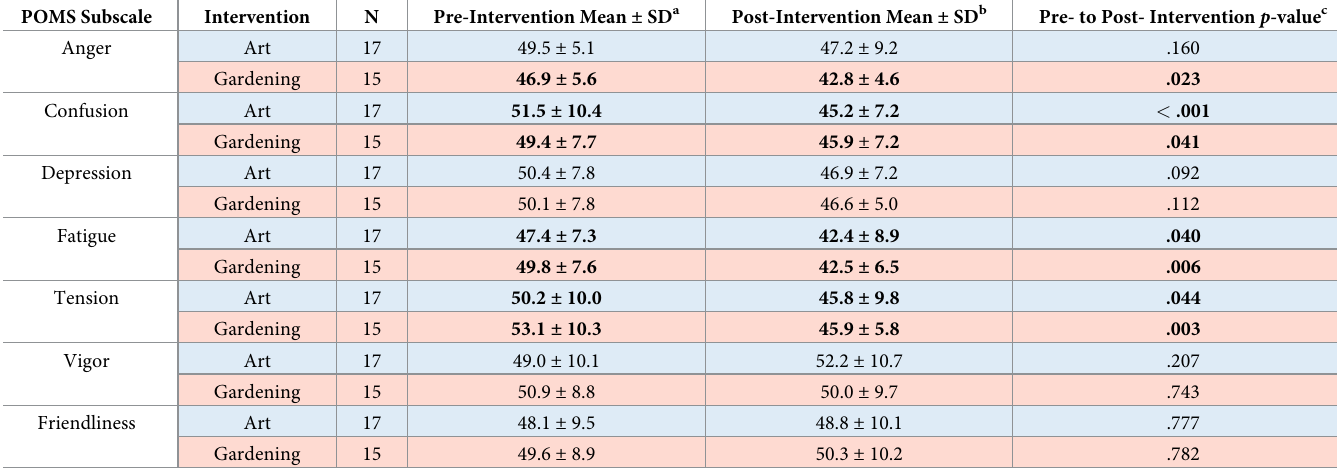
Table 8. POMS subscale statistics for the art and gardening interventions.